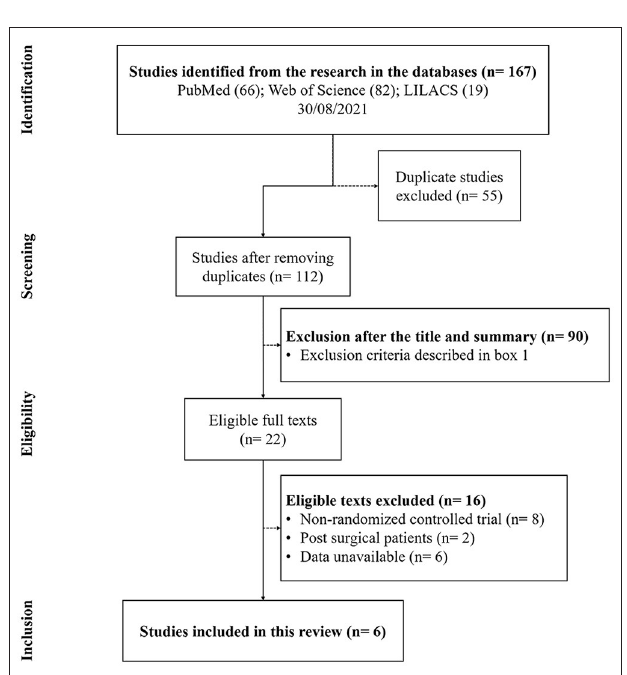
FIGURE 1 | PRISMA flowchart of studies evaluated and